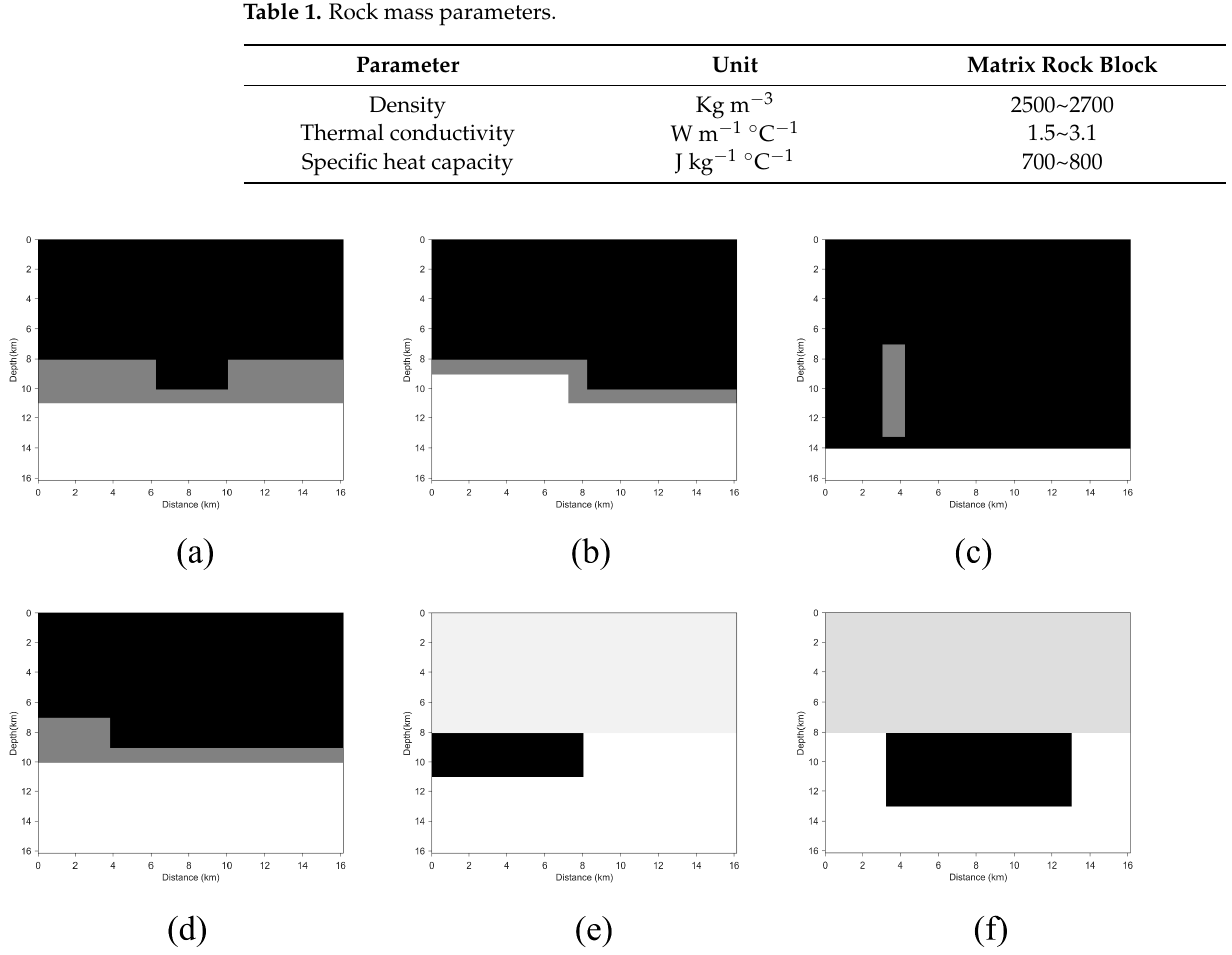
Figure 3. The density parameters of six geological models ( a – f ) for the training data set: ( a ) Graben model, ( b ) pleated − structure model, ( c ) magmatic intrusion model, ( d ) platform model, ( e ) mag- matic intrusion model, ( f ) magmatic intrusion model.